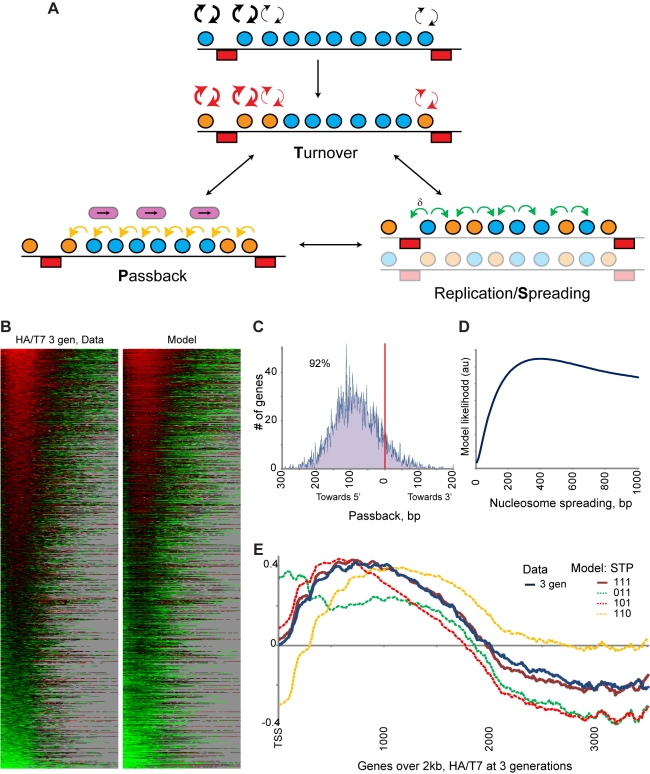
Quantitative modeling reveals three distinct dynamic
processes.(A) Outline of quantitative model. From a given starting distribution,
histones are subject to turnover [15],
transcription-associated lateral movement (“passback”), and
replication-mediated spreading. Model is described in detail in Text
S1. (B) The model captures major features of the experimental
data. HA/T7 ratios for experimental data and model predictions are shown
for all genes as a heatmap. (C) Distribution of lateral passback
parameter (per generation) for all genes. Note that the vast majority
(92%) of genes were associated with retrograde 3′ to
5′ movement along coding regions. (D) Estimation of
replication-based spreading of maternal histones. Model likelihood
(Text S1) is plotted on the y-axis for
various width spreading distributions (defined as 1 standard deviation
of the Gaussian describing histone movement at replication—see
Text
S1 for model details). (E) Eliminating any of the three model
features worsens fit to data. Plotted are averages at 3 generations for
genes over 2 kb for data versus predictions of various models
(“STP” refer to replication-mediated Spreading,
replication-independent Turnover, and Passback). Note that the model
eliminating turnover underestimates turnover effects, as histones that
spread or are passed over the 5′ end of the gene are still
eliminated in this model (i.e., in this model we effectively only
eliminate turnover within CDS, not in intergenic regions), providing
another basis for high loss of 5′ histones.